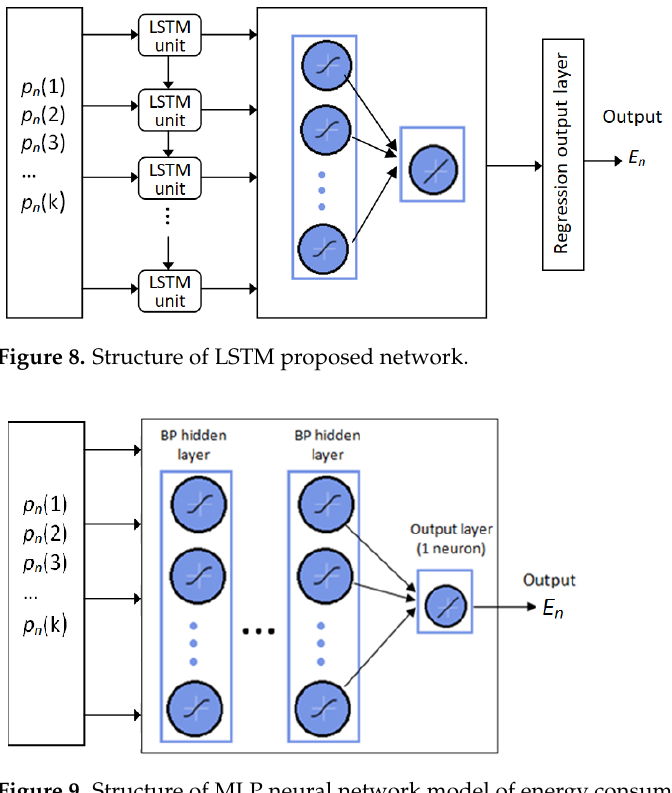
Figure 9. Structure of MLP neural network model of energy consumption.